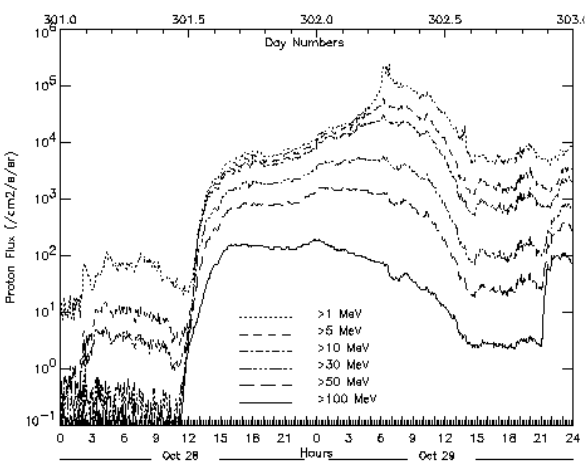
Fig. 1. Proton fluxes exceeding 100, 50, 30, 10, 5, and 1MeV, GOES-11, 28–29 October 2003.